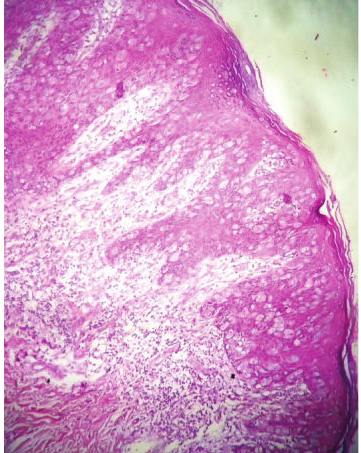
Figure 4: HE, 100x, Paget cells with clear cytoplasm inside the epidermis.